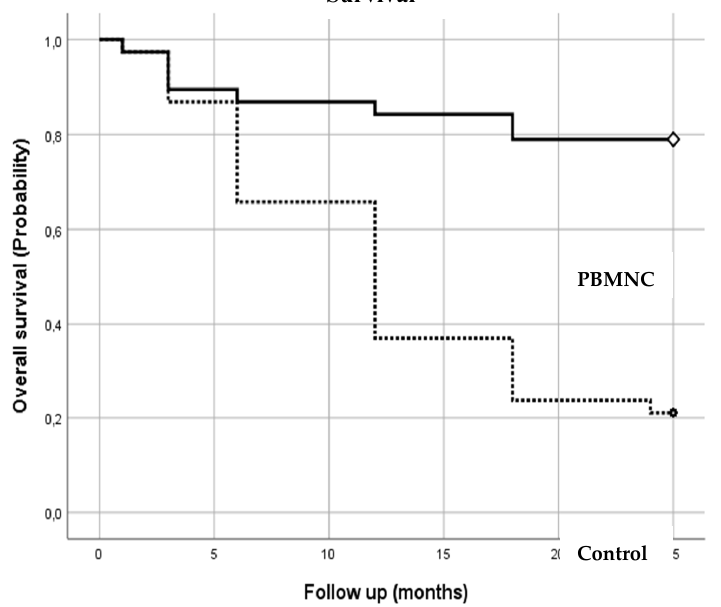
Figure 3. Overall survival: the number of patients alive in both groups during the follow-up period (1–24 months).